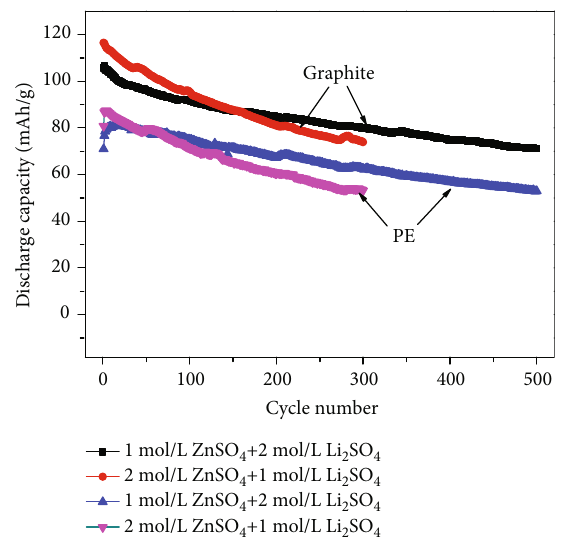
Figure 1: The cycling performance of LiMn di ff erent cathode current